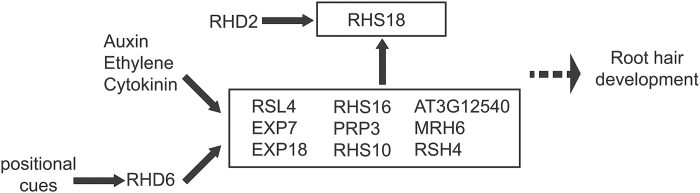
A proposed model for how phytohormones regulate root hair differentiation. This predicted regulation model is based on our qRT-PCR data and multiple microarray datasets (Yi et al., 2010; Bruex et al., 2012; Nishiyama et al., 2012).